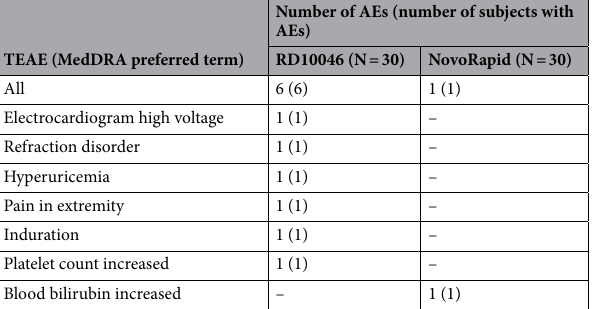
Table 3. Treatment-emergent adverse events for all causalities. MedDRA version 21.1. N number of subjects studied, TEAE treatment-emergent adverse events, AE adverse event.